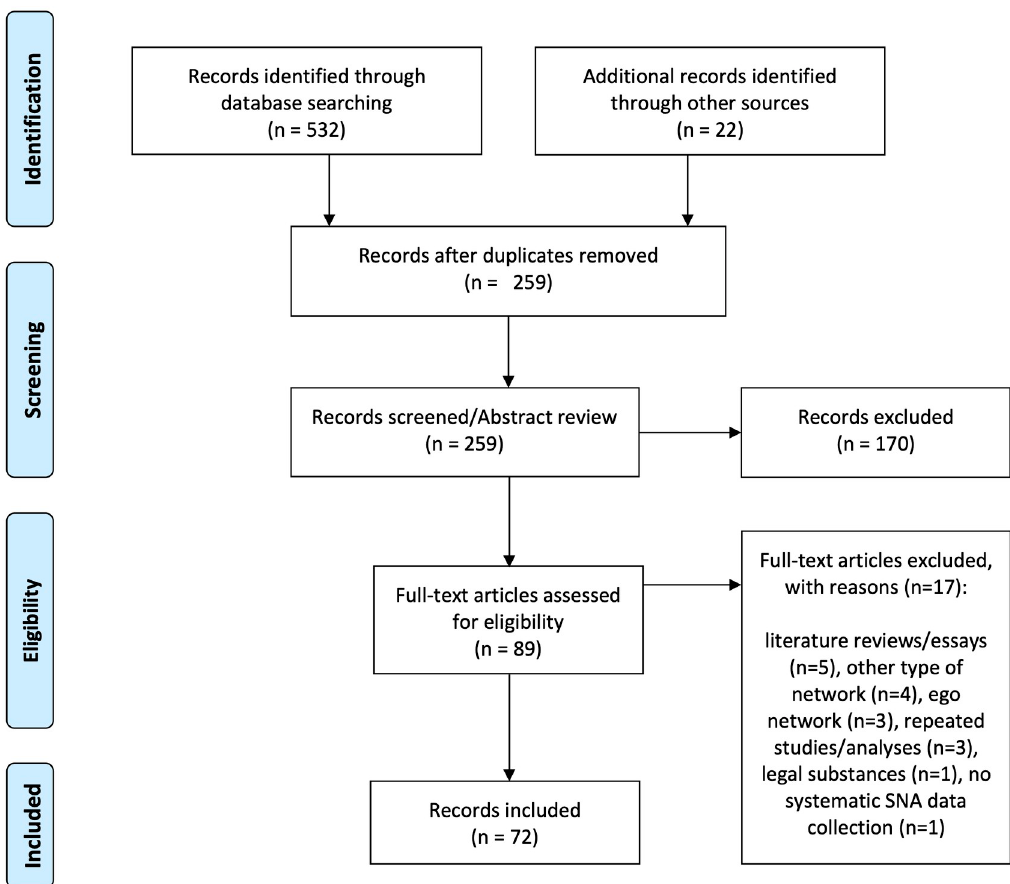
Fig 1. PRISMA 2009 flow diagram. Study selection process. From : Moher D, Liberati A, Tetzlaff J, Altman DG, The PRISMA Group (2009). P referred R eporting I tems for S ystematic Reviews and M eta- A nalyses: The PRISMA Statement. PLoS Med 6(7): e1000097. doi:10.1371/journal.pmed1000097 For more information, visit www.prisma-statement.org.